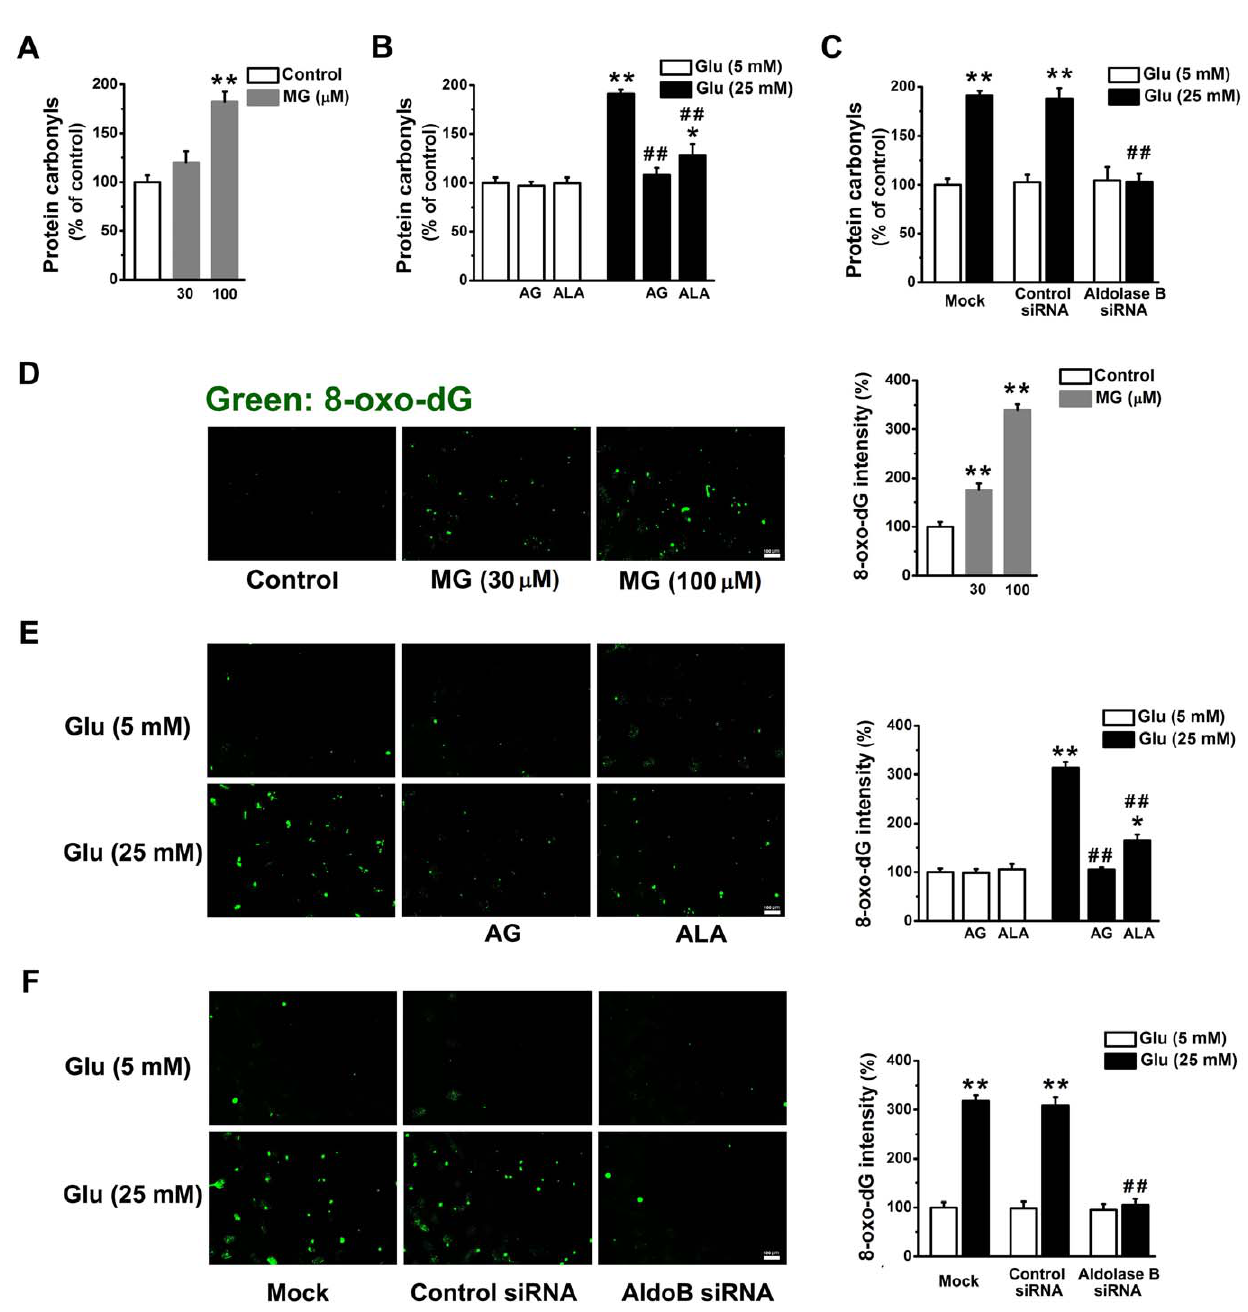
Figure 4. Knockdown of aldolase B prevented protein and DNA oxidation in high glucose-treated EA. hy926 cells. Levels of protein carbonyls (A) in cells treated with exogenous MG (** P , 0.01 vs. control), (B) in cells treated with glucose in the presence or absence of aminoguanidine (AG, 1 mM) and alagebrium (ALA, 100 m M) (* P , 0.05, ** P , 0.01 vs. 5 mM glucose; ## P , 0.01 vs. 25 mM glucose), and (C) in cells transfected with control or aldolase B siRNA, or only transfection agent (mock) (** P , 0.01 vs. 5 mM glucose; ## P , 0.01 vs. control siRNA). Levels of 8- oxo-dG (D) in cells treated with exogenous MG (** P , 0.01 vs. control), (E) in cells treated with glucose in the presence or absence of aminoguanidine (AG, 1 mM) and alagebrium (ALA, 100 m M) (* P , 0.05, ** P , 0.01 vs. 5 mM glucose; ## P , 0.01 vs. 25 mM glucose), and (F) in cells transfected with control or aldolase B siRNA, or only transfection agent (mock) (** P , 0.01 vs. 5 mM glucose; ## P , 0.01 vs. control siRNA). Fluorescence intensity of 8- oxo-dG per cell was measured using Image J. doi:10.1371/journal.pone.0041495.g004 of alagebrium partially reduced the formation of protein carbonyls similar to that induced by 25 mM glucose ( P = 0.26) (Figs. 4D, 4E). in high glucose-treated cells ( P , 0.01) (Figs. 4B, 4C). High glucose-increased 8-oxo-dG levels were prevented by aminoguanidine or by transfection with aldolase B siRNA, and MG (30 or 100 m M, 3 days) elevated levels of 8-oxo-dG (a partially reduced by alagebrium ( P , 0.01) (Figs. 4E, 4F). marker of DNA oxidation) in EA. hy926 cells ( P , 0.01) (Fig. 4D). The increase of 8-oxo-dG levels induced by MG (100 m M) was